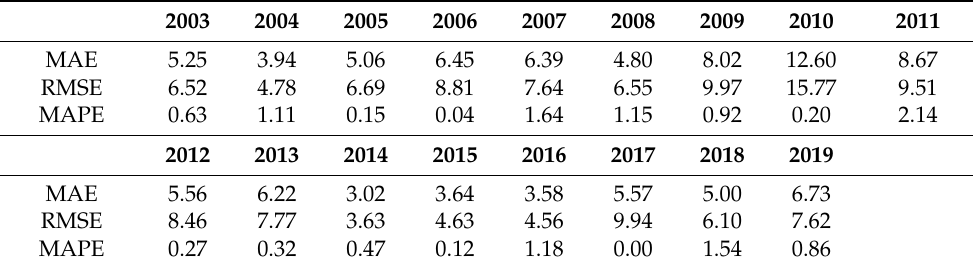
Figure 9. The temporal ‘global’ WQI series. Table 6. Goodness of fit indicators in the temporal ’global’ WQI series modeling.